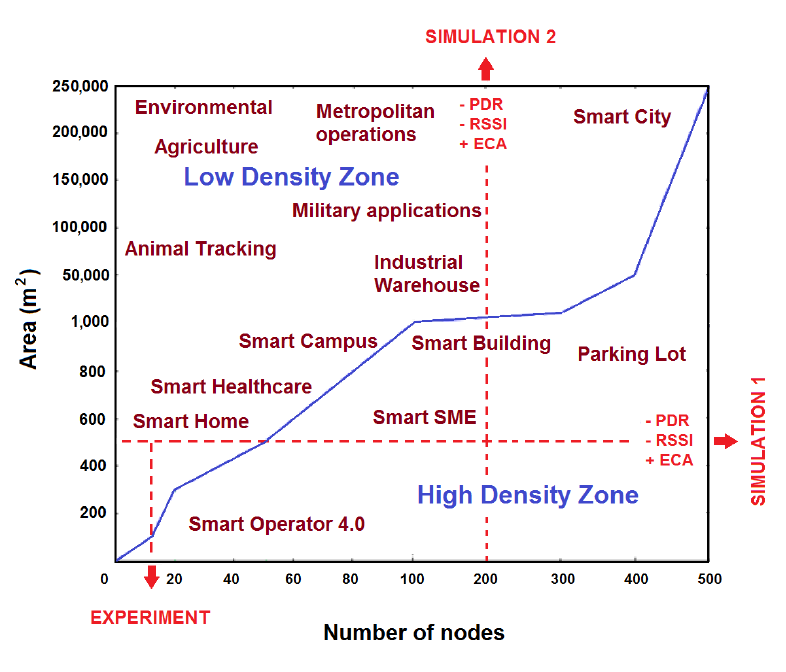
Figure 1. WSN applications based on node